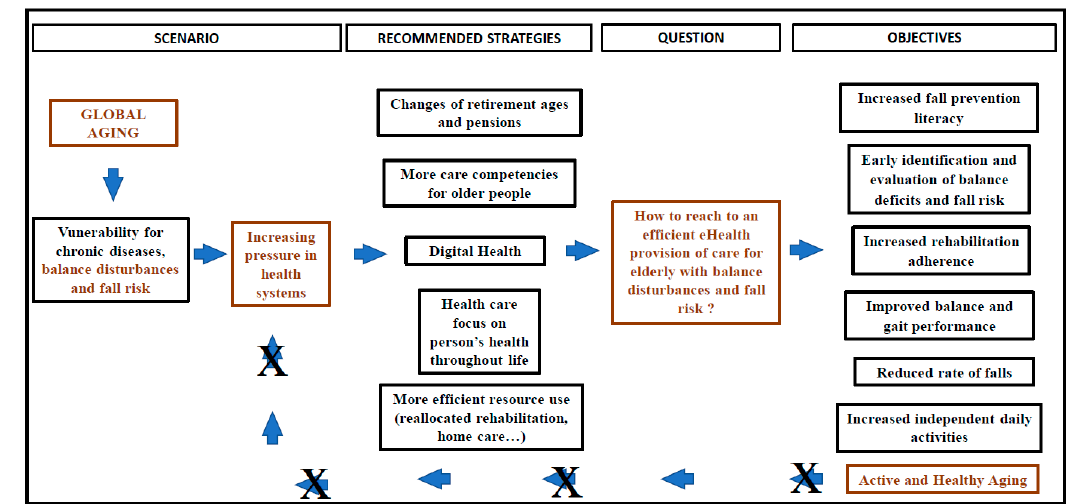
Figure 1. eHealth Framework for the elderly with balance disorders care provision. (Authors own elaboration).